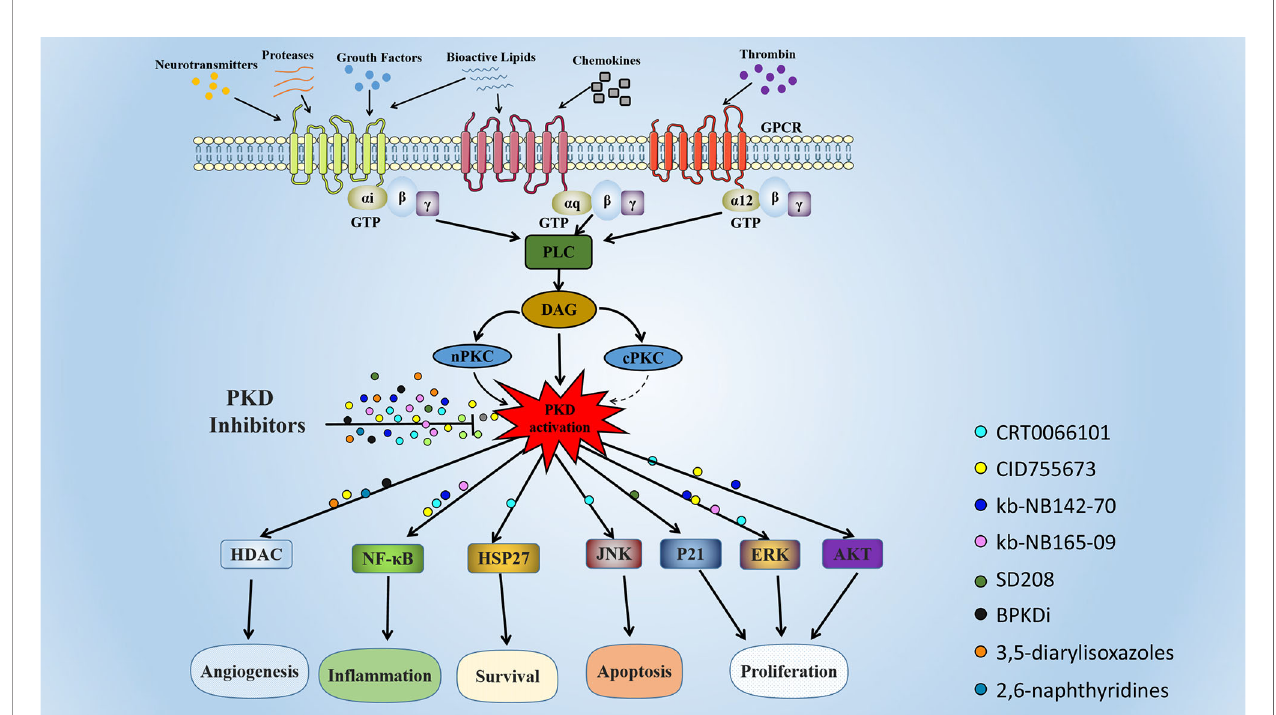
FIGURE 3 | Signaling pathways and biological functions of PKD. The PKDs are activated by many substances, including phorbol ester, platelet-derived growth factor, and G protein-coupled receptor ligands. These extracellular stimuli activate intracellular phospholipase C (PLC) by binding to cell surface receptors. Activated PLC catalyzes the production of intracellular second messenger diacylglycerol (DAG), which recruits PKD and PKC to the plasma membrane. Activated PKC phosphorylates PKD at two serine residues (Ser 738 and 742 in human PKD1), resulting in PKD activation. Activated PKD regulates multiple biological functions, including angiogenesis, in fl ammation, cell proliferation, apoptosis, and survival. The colored globules represent the different PKD small molecule inhibitors, and the globules on the arrow represent the action of PKD inhibitors in different cellular